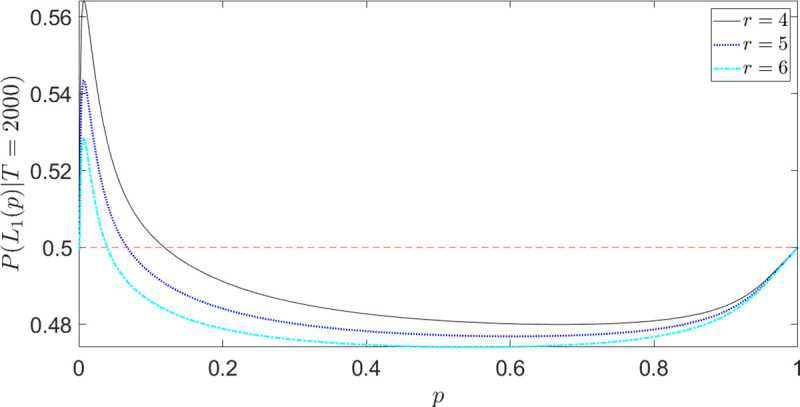
Fourfold pattern of risk attitudes (gain-side): Time-constrained choice probabilities as a function of outcome probabilities (Eq (19)).Differently from Fig 3A (first line of Eq (16)), P(L1(p)|T)→0.5 as p→0, as it should. In this example we set D =10, T = 2000 and scan different values of the CARA coefficient r.